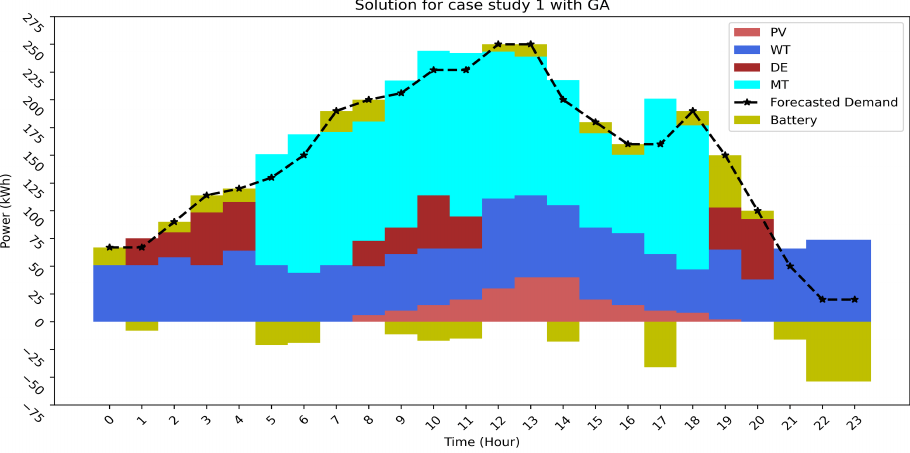
Figure 7. UC uses BESS based on the GA approach.